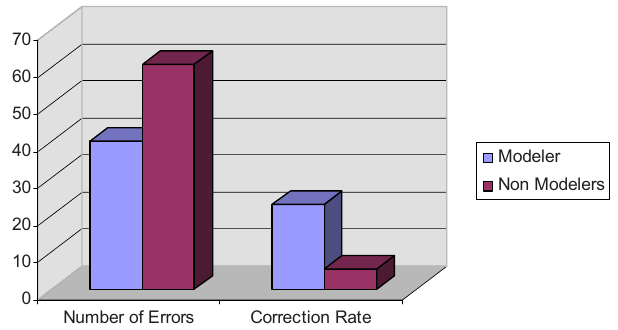
FIG. 8. (cid:1) Color online (cid:2) Graph of percentage of errors produced and correction rates per group. The modeling students commit sig- nificantly fewer errors while correcting a